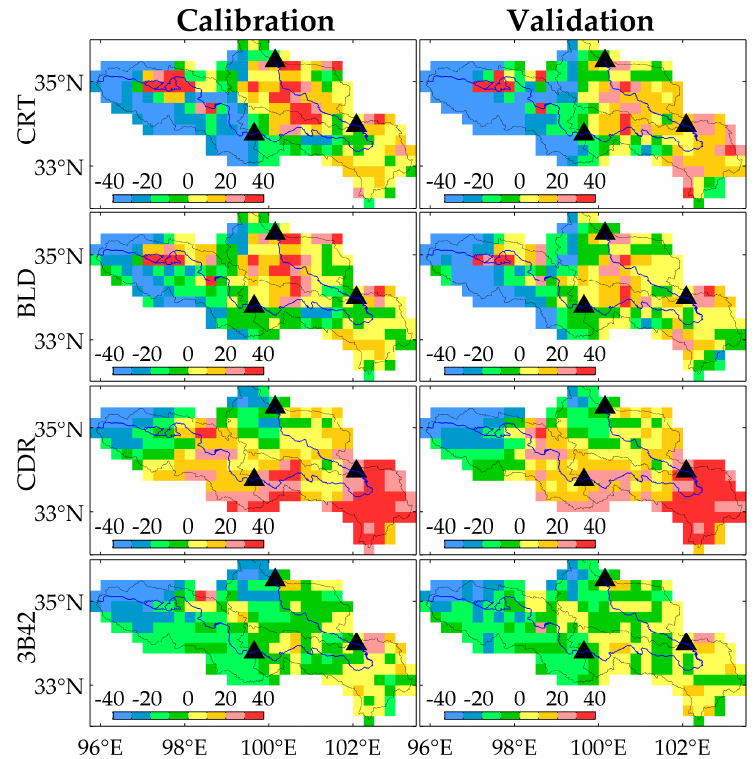
Figure 3. RBs (%) from SGPEs against CMA estimates for both calibration (2001–2005) and validation (2006–2012) periods.